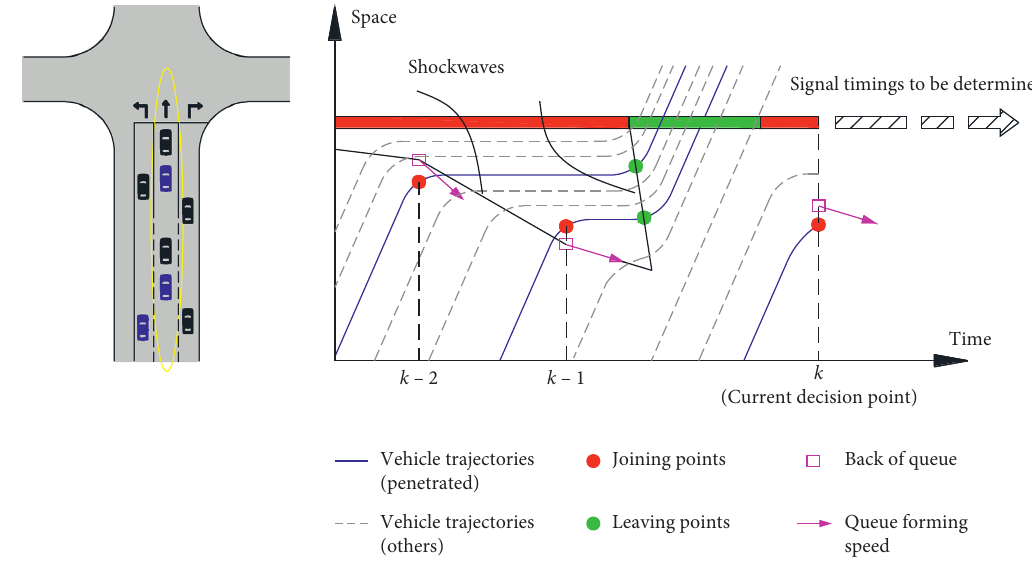
Figure 1: Overview of the QIA algorithm.